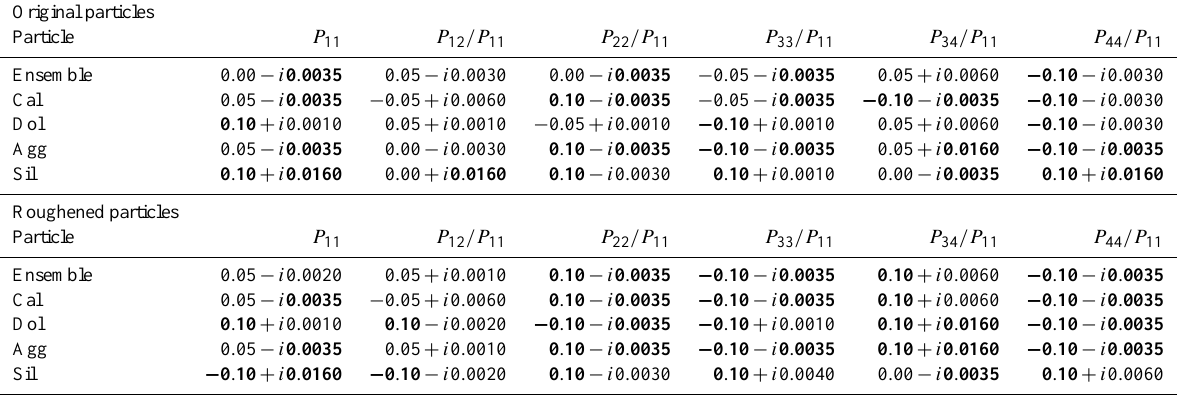
Table 2. Complex refractive index errors for the fitted shape distribution. The values in bold correspond to retrieved refractive indices at the boundary of our refractive index domain and therefore could be even more erroneous in